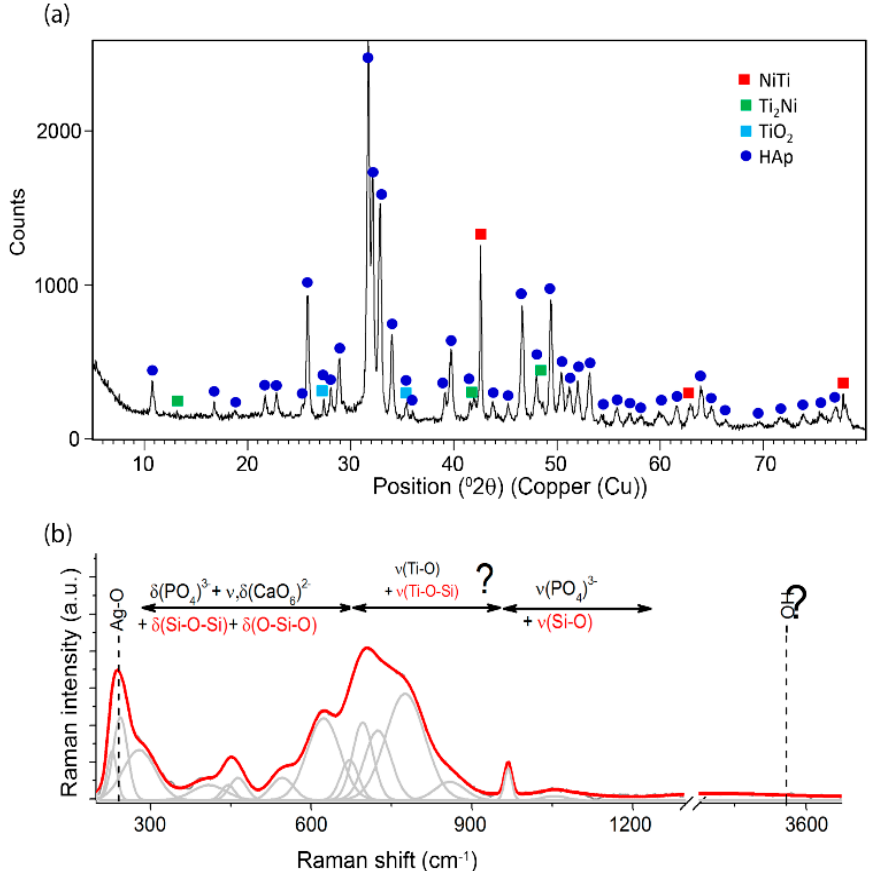
Figure 25. Following thermal treatment, an XRD signal was obtained for coating 5:1 (50 V, 120 s), along with an example Raman spectrum ( a ). The Voigt function was used to fit the bands with the fewest possible components ( b ). Reprinted with permission from [141]. Copyright 2021 MDPI. Dis-